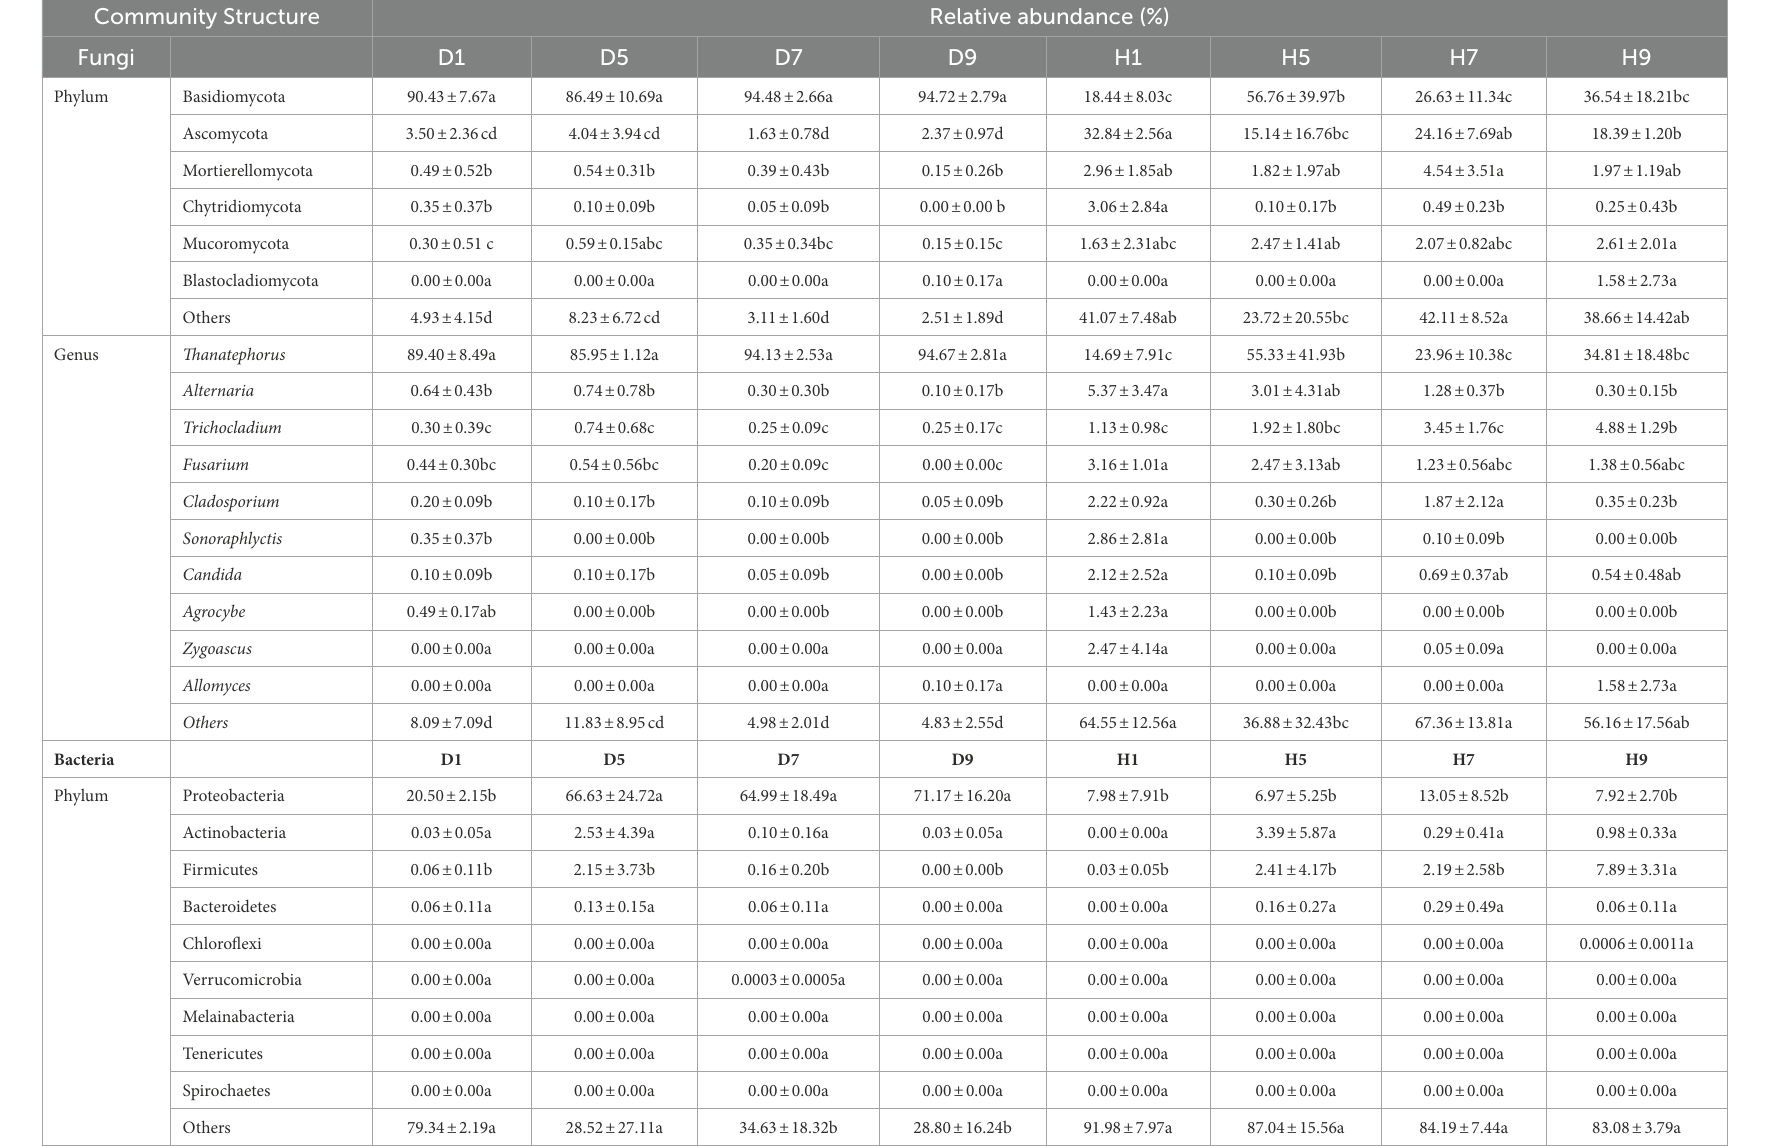
TABLE 3 List of top 10 dominant taxa and their relative abundance in the fungal and bacterial community of the group. Community